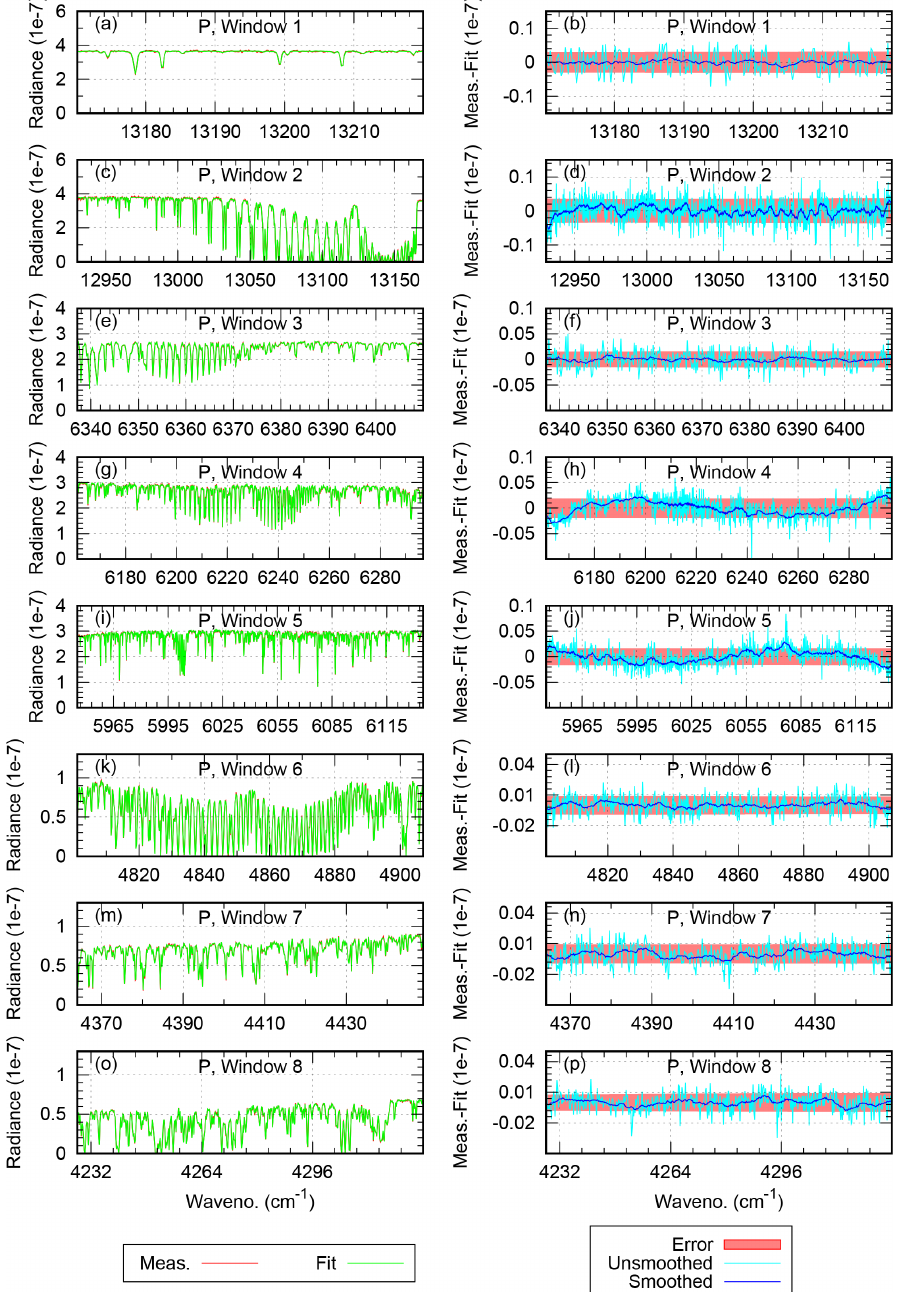
Figure 9. Same as Fig. 8, but for GOSAT-2.